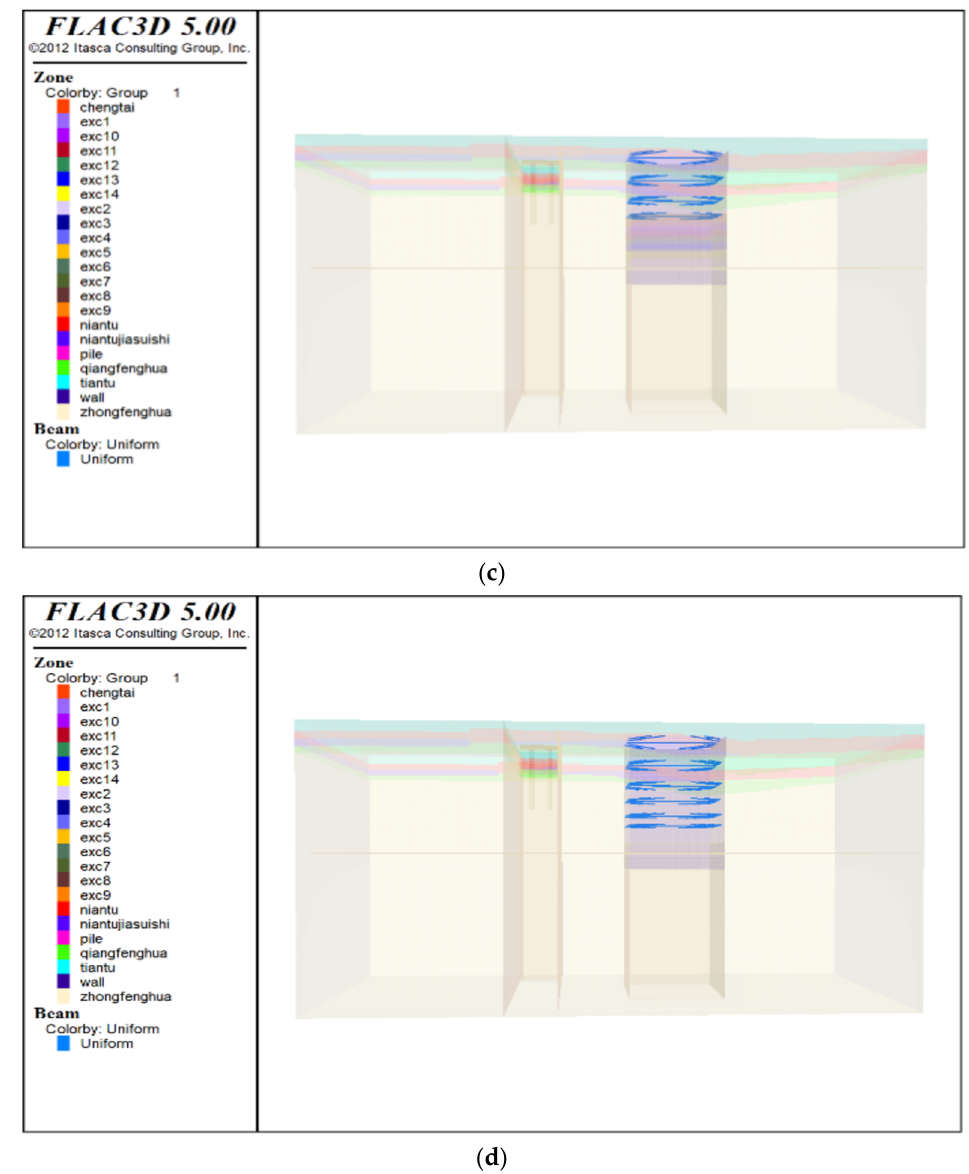
Figure 15. FEM simulations of foundation pit excavation and support. ( a ) Construction of the concrete support at the first level; ( b ) construction of the steel support at the third level; ( c ) construction of the concrete support at the fourth level; ( d ) construction of the steel support at the sixth level.